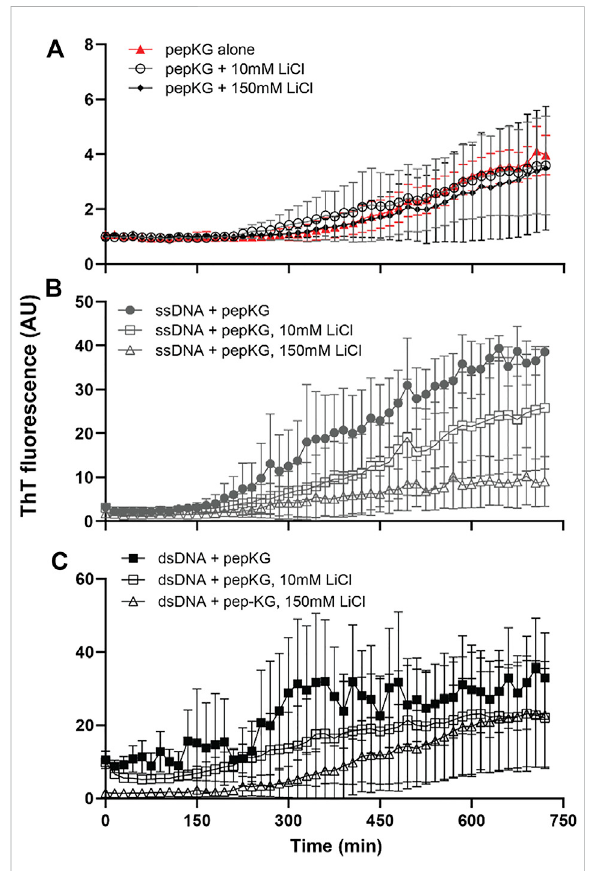
FIGURE 5 Pep-KG association with DNA can be modulated by LiCl. Cross- β assembly of Pep-KG, Pep-KG/ssDNA, and Pep-KG/ dsDNA [ (A – C) , respectively] monitored by ThT fl uorescence in the presence of different LiCl concentrations, 10 and 150 mM. All assemblies were incubated in 40% MeCN at 37 ° C with dsDNA and ssDNA added at a 1:1 charge ratio, 41.6 μ M dsDNA and 83.3 μ M ssDNA, with 5 μ M ThT that was added at the beginning of the assembly. Itshouldbenotedthat, whileThT hasbeen thestandard probeforidentifyingthepresenceofcross- β assembly,itisunclear whether it plays a role in stabilization of the architecture. Thus, all assembly rates discussed here are relative to the baseline Pep-KG incubated with ThT. Error bars are 95% CI values and all samples are n =